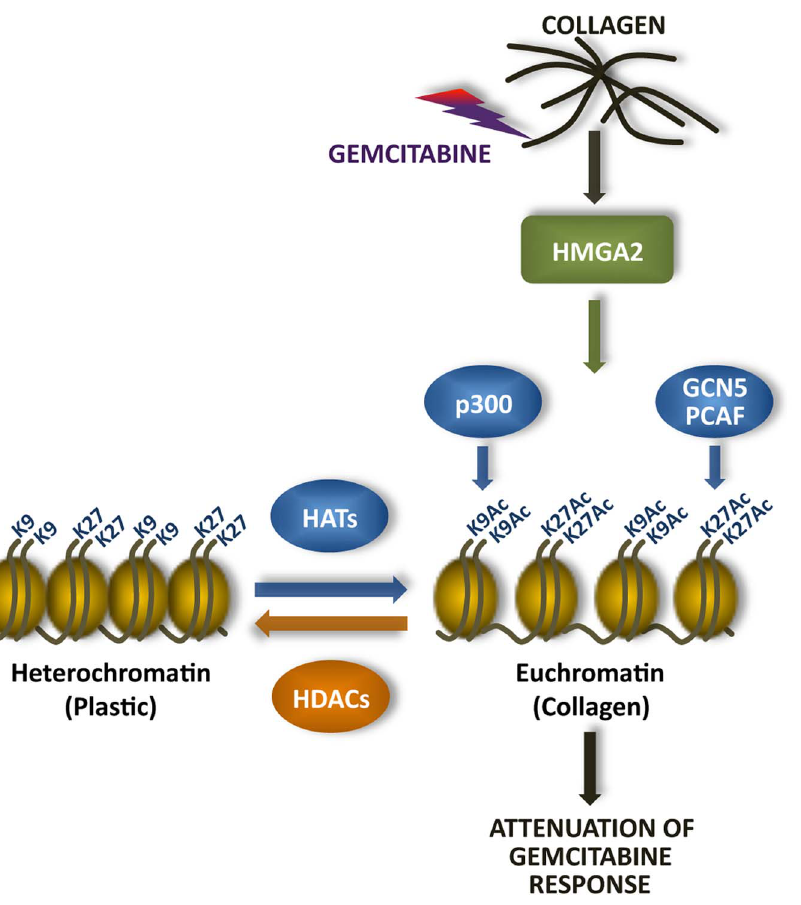
Figure 6. Regulation of gemcitabine resistance by HMGA2 and HATs. Previously, we had published that the collagen microenvironment induced HMGA2 expression [Dangi-Garimella S et al, [6]]. We now demonstrate that PDAC cells in the collagen microenvironment induce HMGA2- dependent HAT expression and histone H3 acetylation, suggesting that the collagen microenvironment promotes euchromatin formation. This signaling pathway allows PDAC cells to resist the effects of gemcitabine in the collagen microenvironment.